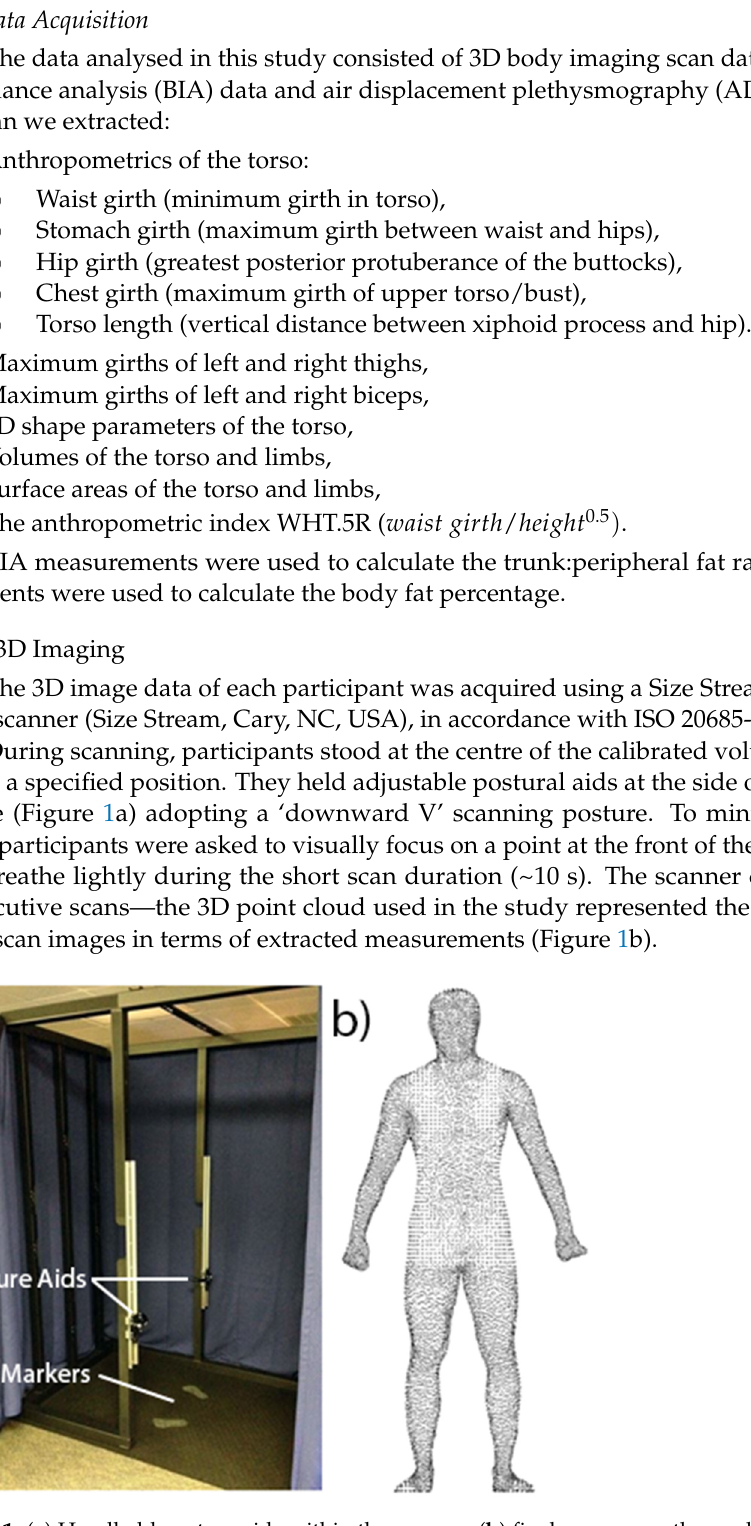
Figure 1. ( a ) Handheld posture aids within the scanner, ( b ) final scans were the median of three with respect to extracted anthropometrics.